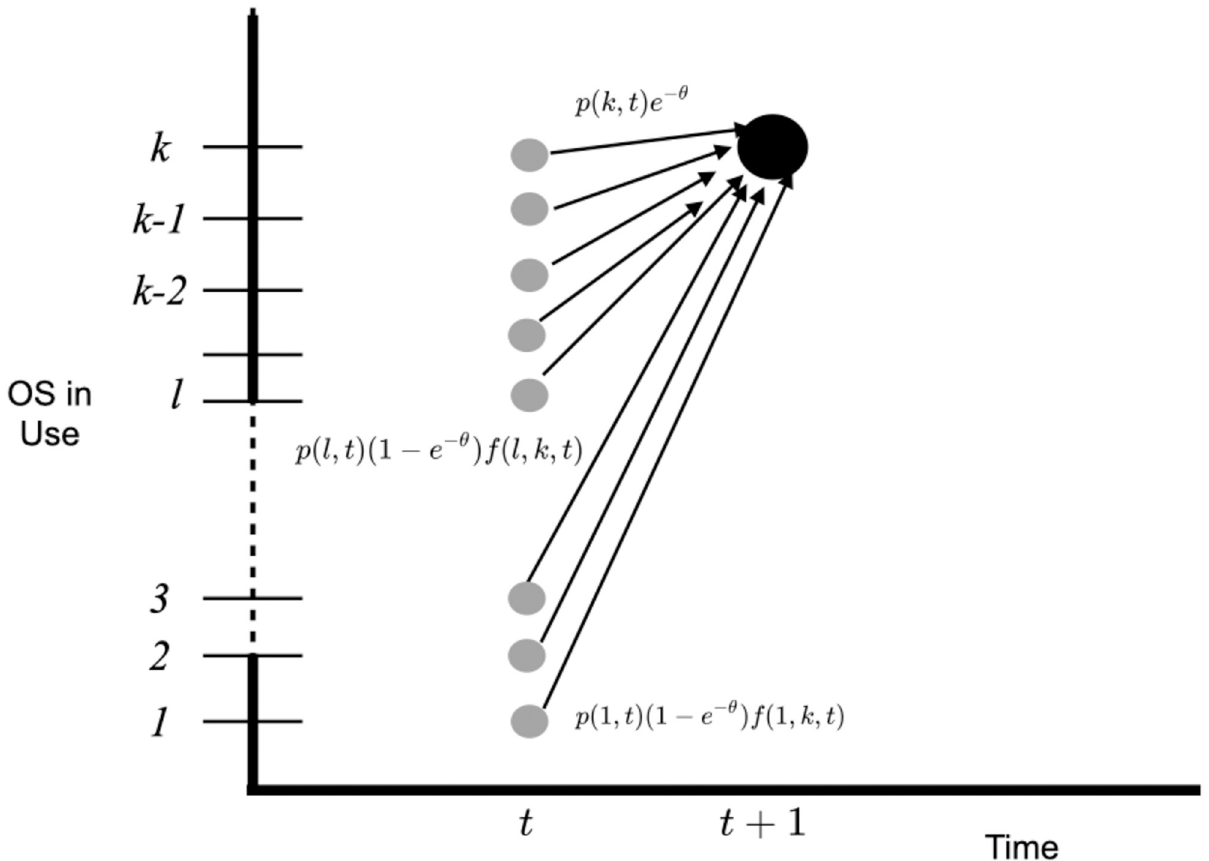
Fig 5. To derive the forward equation for p ( k , t ), we use the method of thinking along sample paths. If OS ( t + 1) = k , either OS ( t ) = k and no transition occurred (with probability e − θ ), or the OS ( t ) = l , where l = 1, 2, 3, .. k − 1, and transition (with probability 1 − e − θ ) occurred from OS ( t ) = l to OS ( t + 1) = k (probability f ( l , k , t